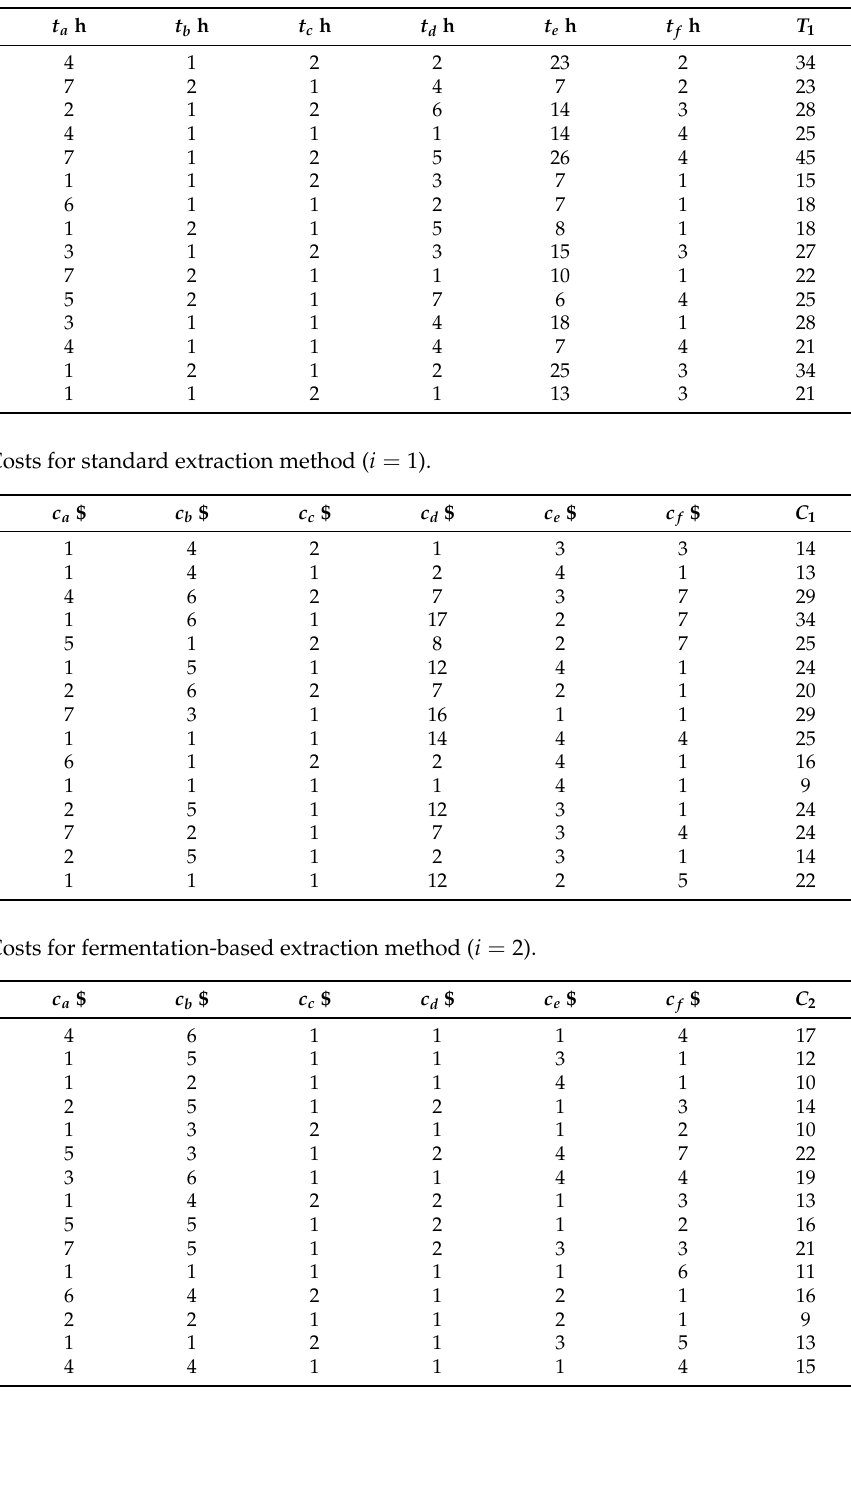
Table A2. Processing times for fermentation-based extraction method ( i = 2).